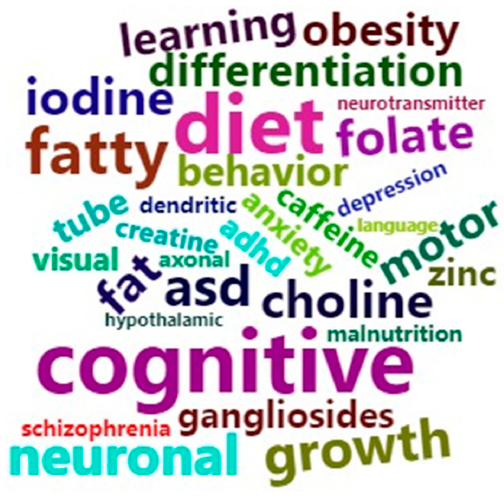
Figure 2. Graphical representation of the nutrients and neurodevelopmental outcomes most frequently encountered during the review. The chosen terms were based on the extraction of data from all included articles using the R cloud program.